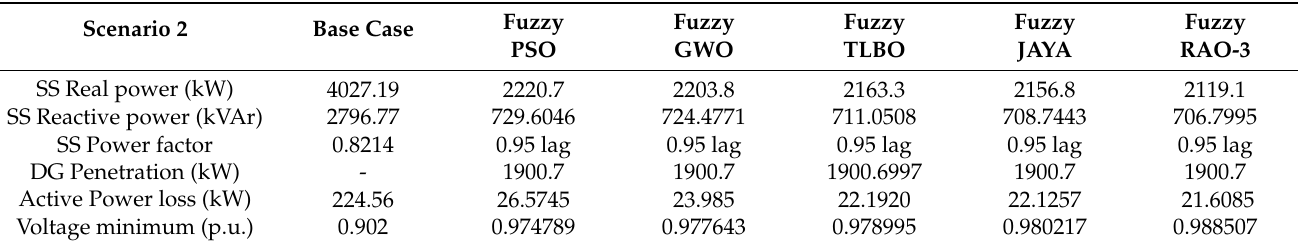
Table 10. Performance comparison of the 69-bus system.